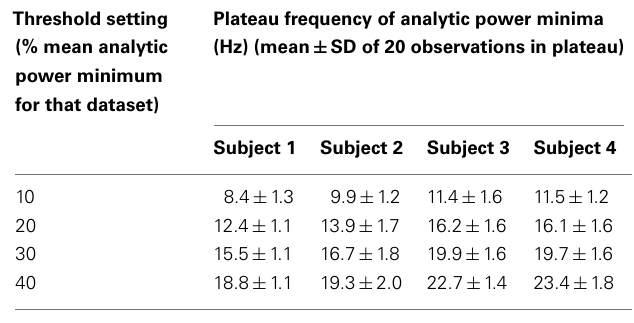
Table 1 | Effect of threshold setting on plateau frequency of analytic power minima in waking